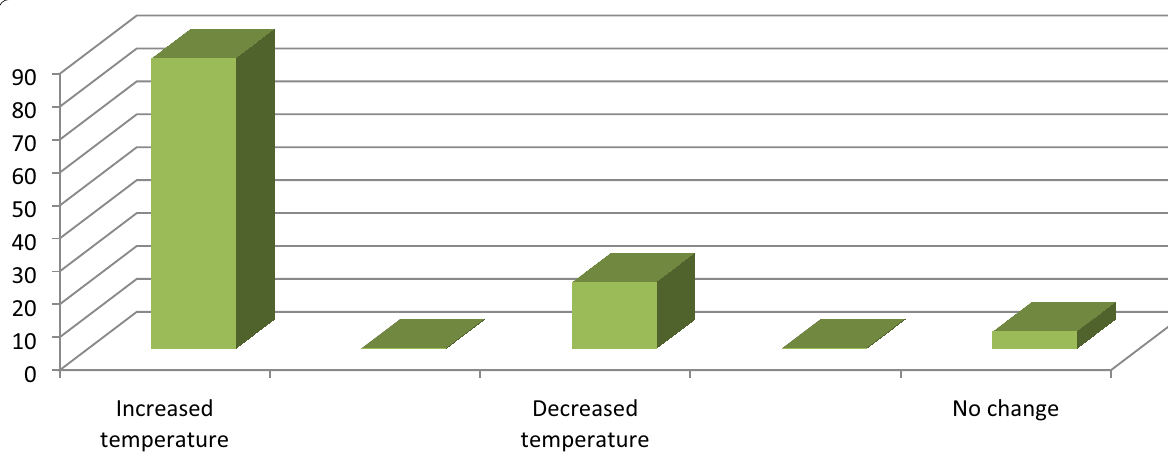
Fig. 3 local perceptions on changes in temperature around the BFR